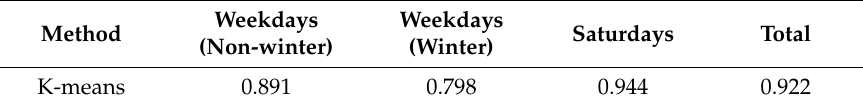
Table 7. External evaluation results of